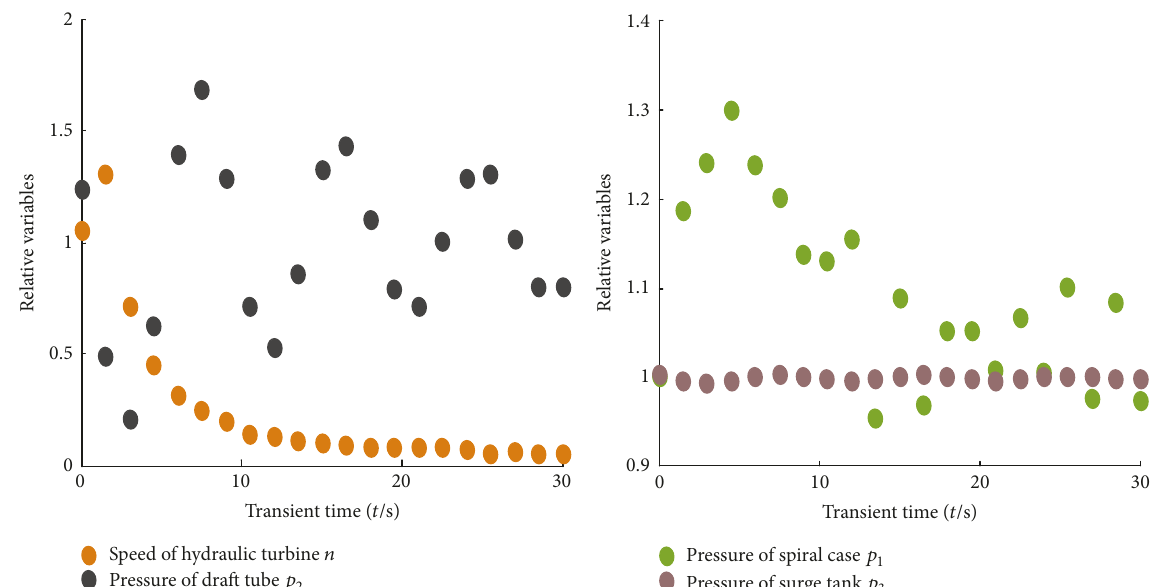
Figure 7: Predictive data of a nonlinear HGS for the load rejection transient process.